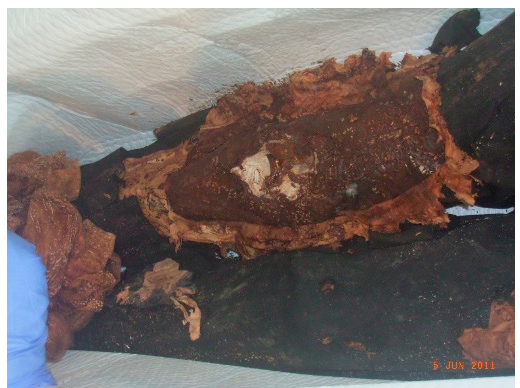
Figure A1. Right knee of the mummified body after removal of the patella. Note the thick layer of bandages around the leg.